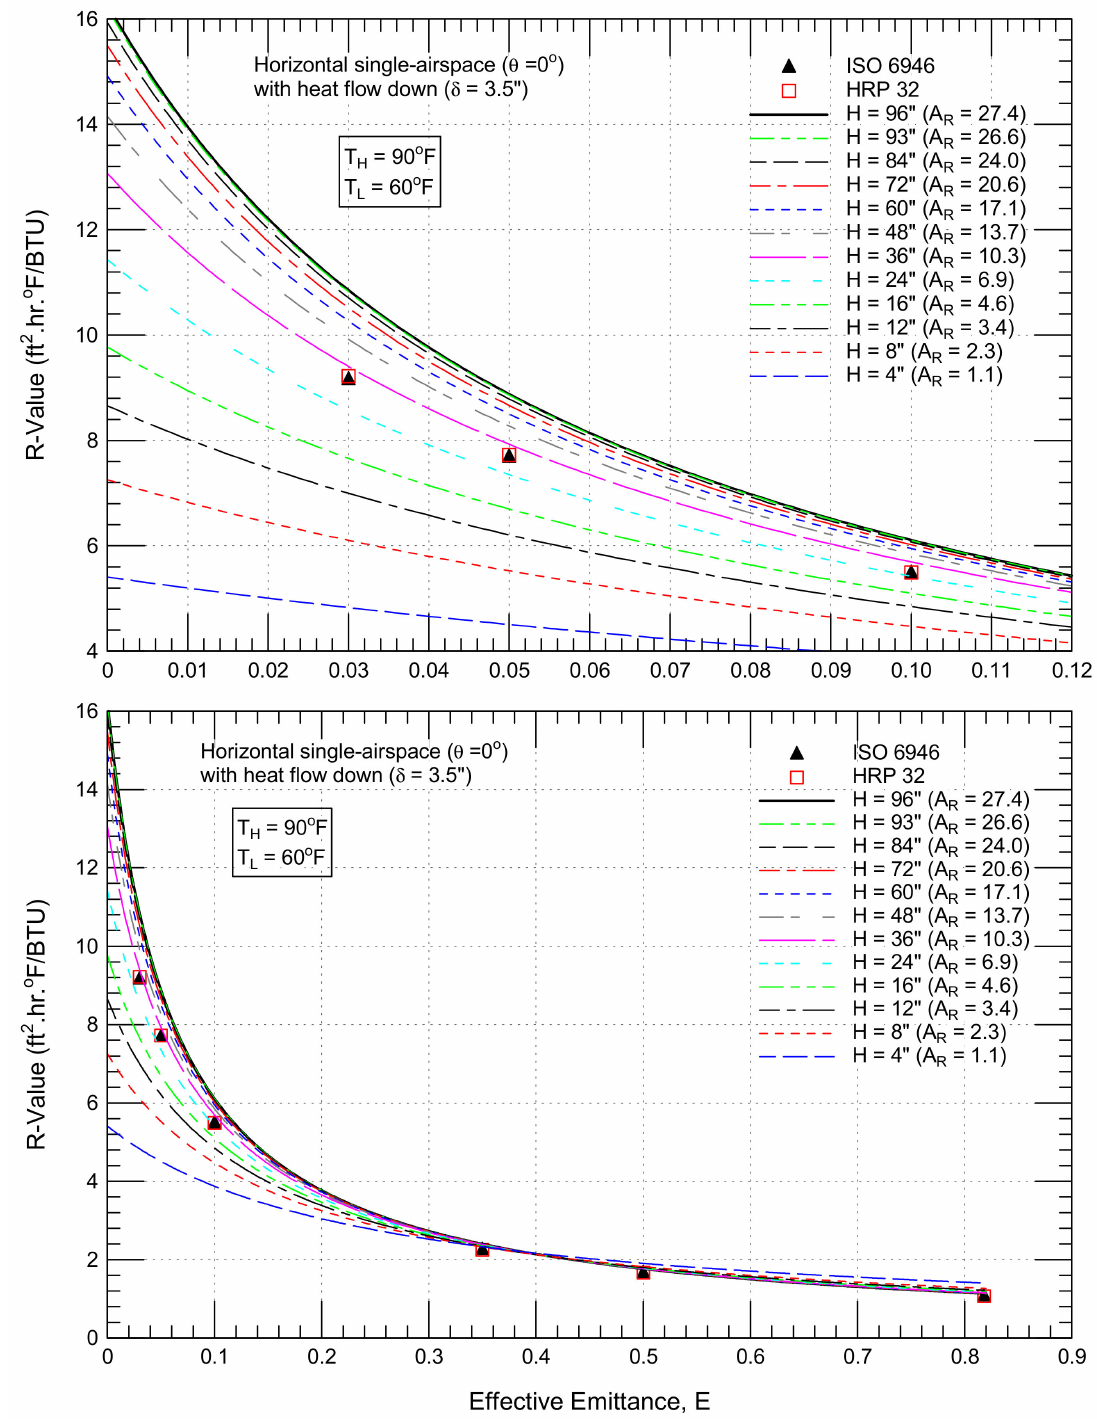
Figure 12. Comparisons of R values of HRP 32 [4], ISO 6946 [9] with present model predictions of various A R for a single airspace subjected to downward heat flow ( θ = 0 ◦ , total δ = 3.5 inches, T H = 90 ◦ F, T L = 60 ◦